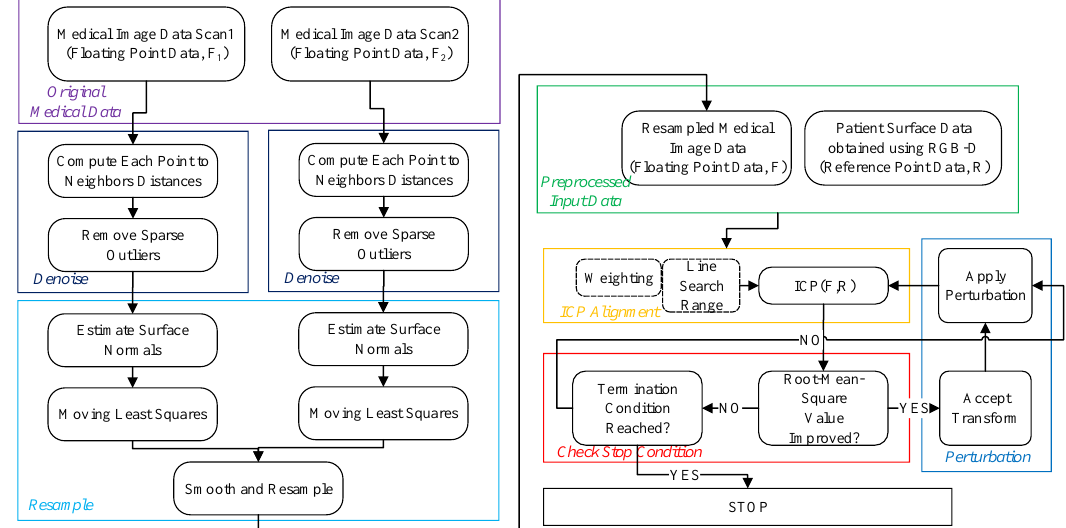
Figure 1. The flowchart of the Denoised-Resampled-Weighted-and-Perturbed-Iterative Closest Points (DRWP-ICP) algorithm.